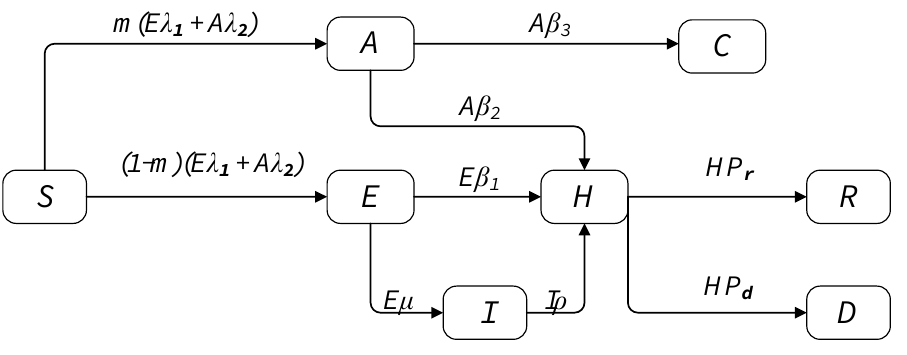
Figure 2. The transition between states of the SEAIHR model.